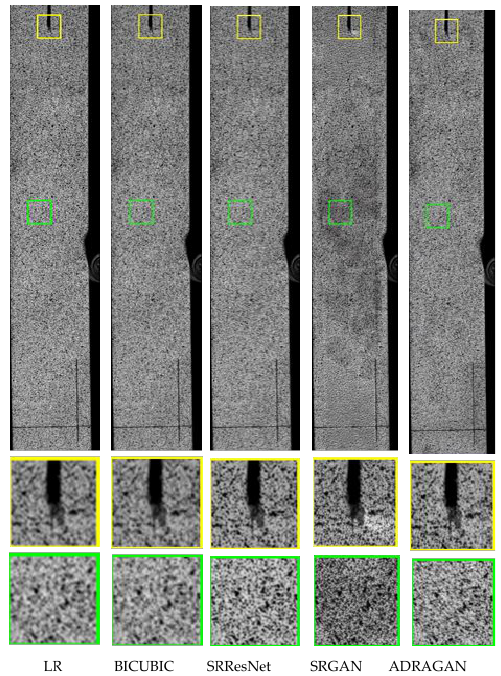
Figure 5. Comparison of reconstructed image effect.